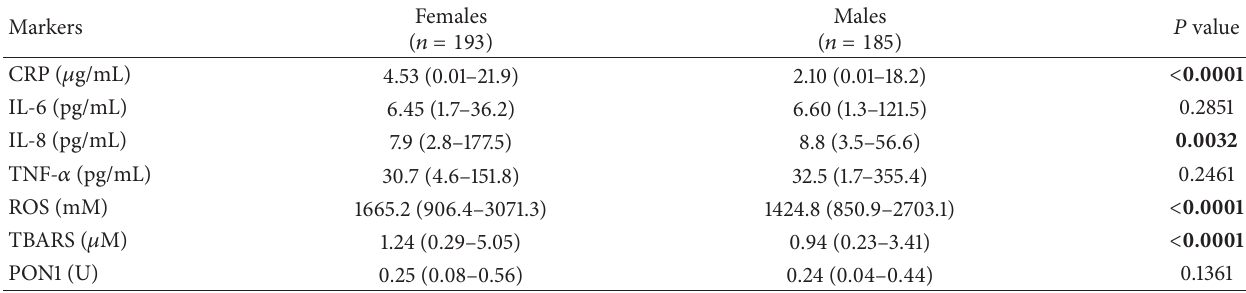
Table 2: Circulating levels of the inflammatory and oxidative stress markers in the studied Arab population. Markers